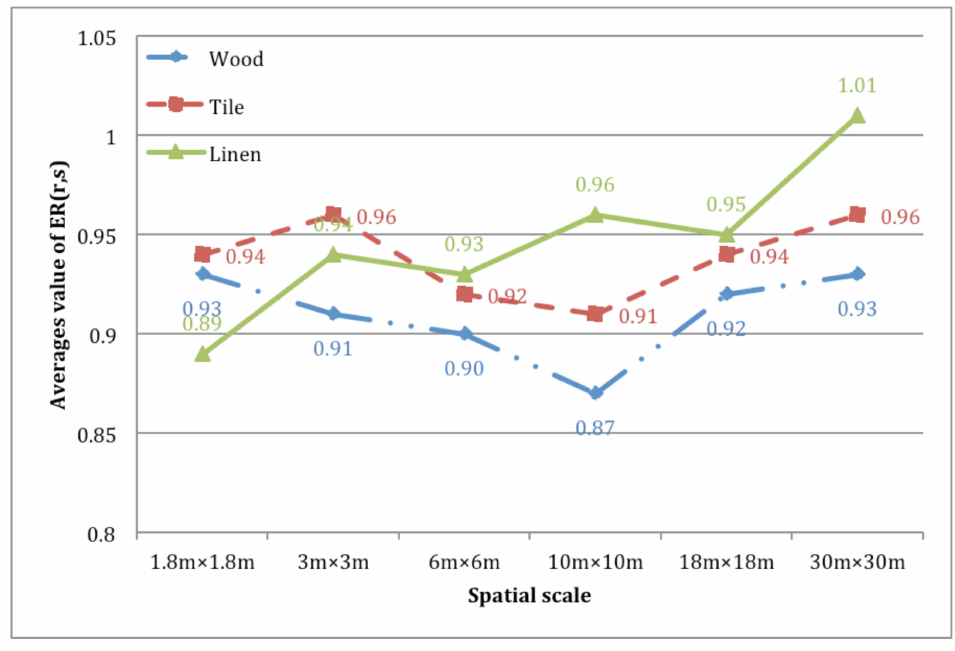
Figure 3. Average values of ER. Table 5. Kruskal–Wallis ANOVA test of ER values between same wall textures at varying room